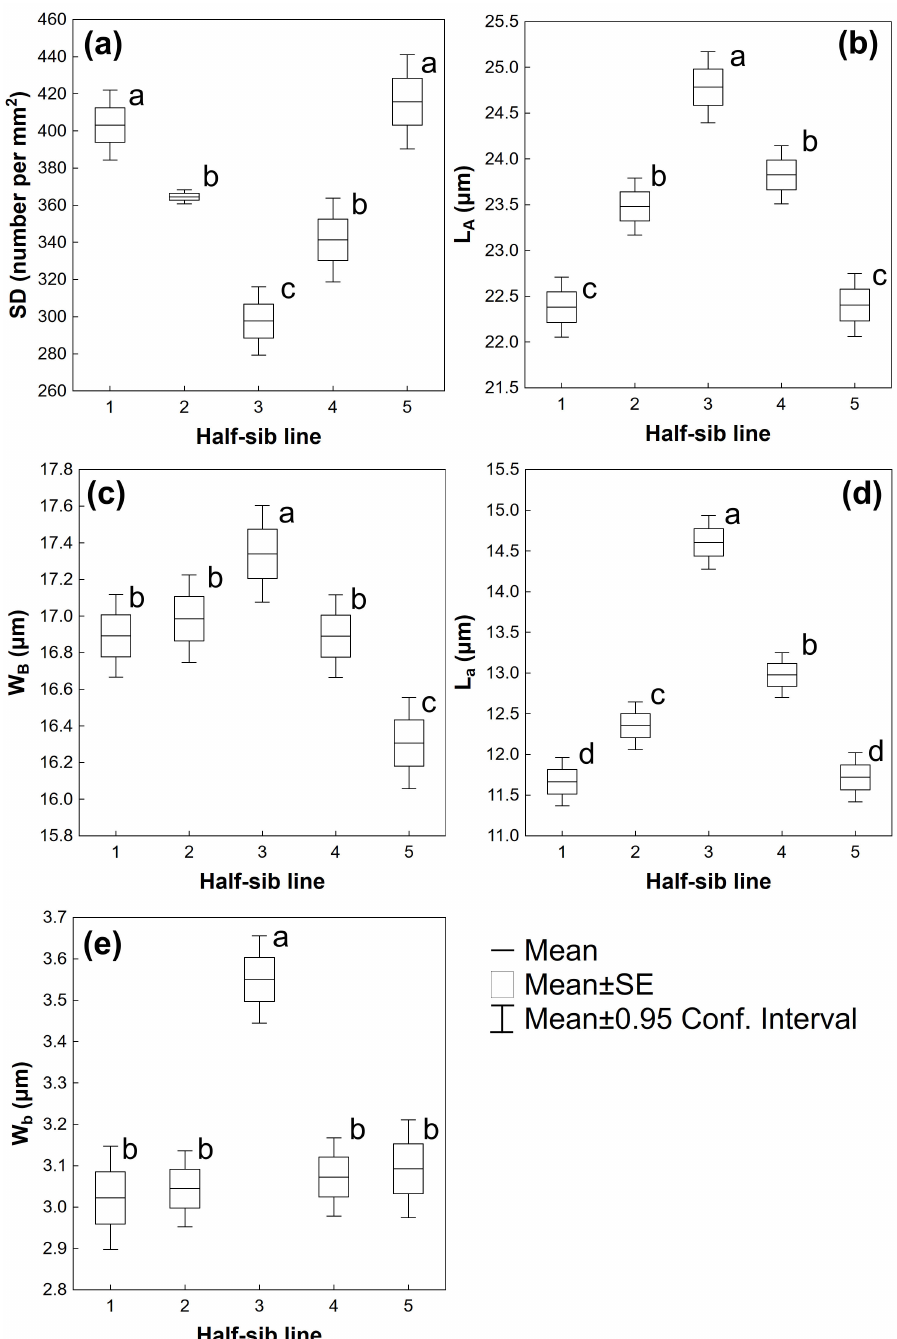
Figure 3. Leaf stomata traits of Q. robur L. half-sib lines. ( a ) Stomatal density per mm 2 (SD, mm 2 ), ( b ) stomata guard cell length (L A , µ m), ( c ) stomata guard cell width (W B , µ m), ( d ) stomatal aperture length (L a , µ m), ( e ) stomatal aperture width (W b , µ m) Values are means ± standard errors ( n = 9; di ff erences of each parameter (SD, L A , W B , L a , W b ) among half-sib lines are reported (Dunkan’s multiple range test; p ≤